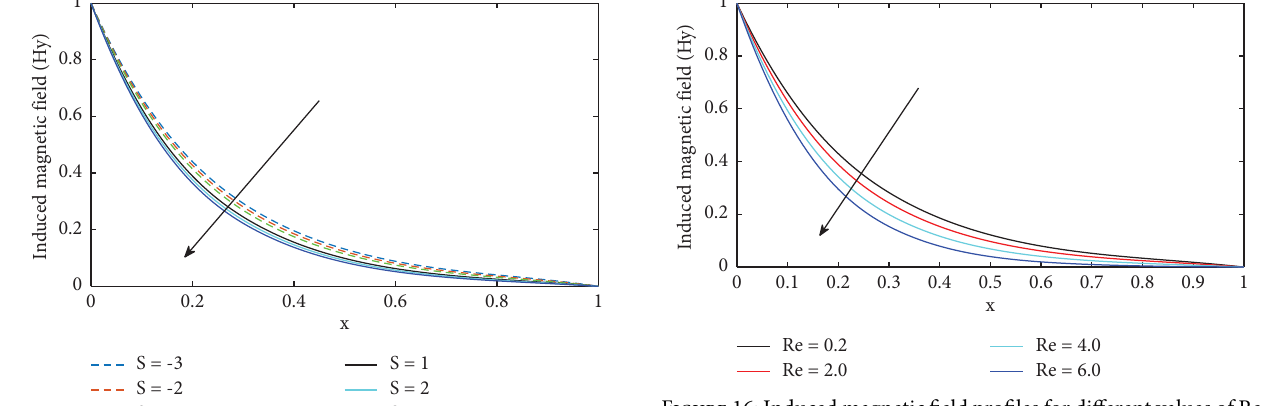
Figure 16: Induced magnetic feld profles for diferent values of Re .